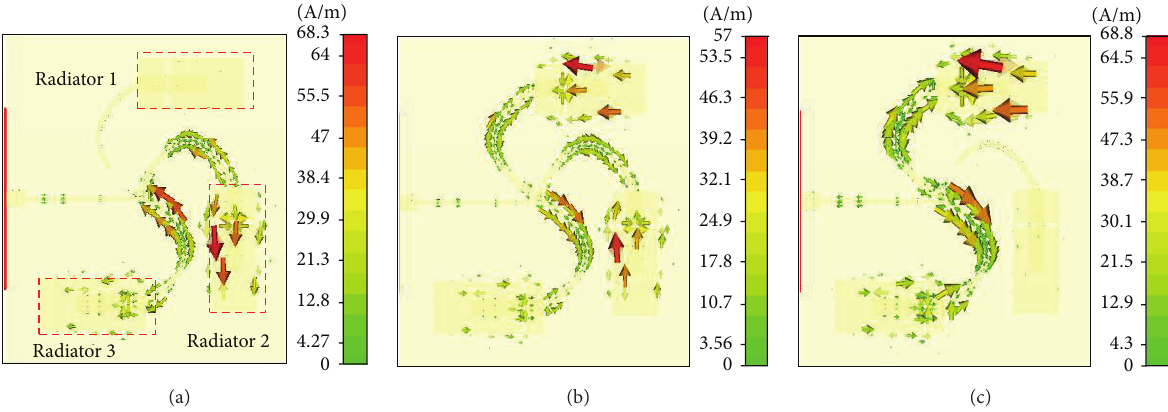
Figure 8: Surface current distributions of the antenna at 2.39 GHz (a) R-RFS B, and C are ON. (b) R-RFS A, B and C are ON. (c) R-RFS A and C are ON. The R-RFS that was not mentioned is in OFF